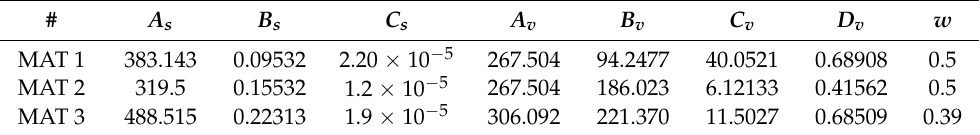
Table 2. Material parameters fitted for three alloys.